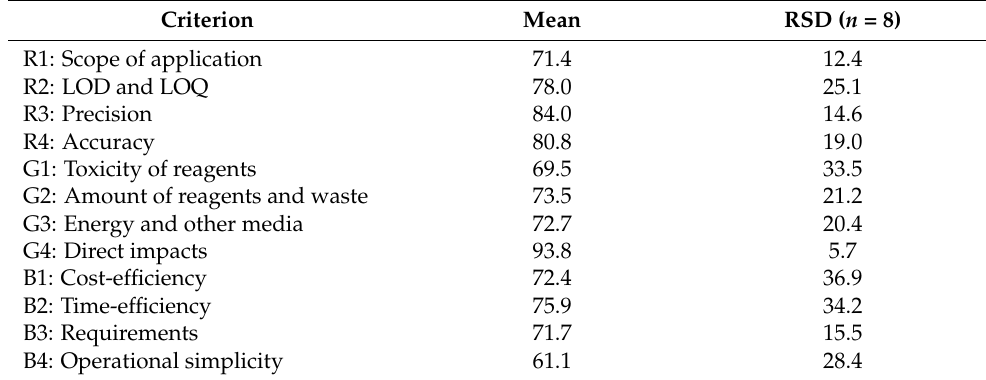
Table 6. The average score for each criterion with the RSD value (%) calculated for all eight